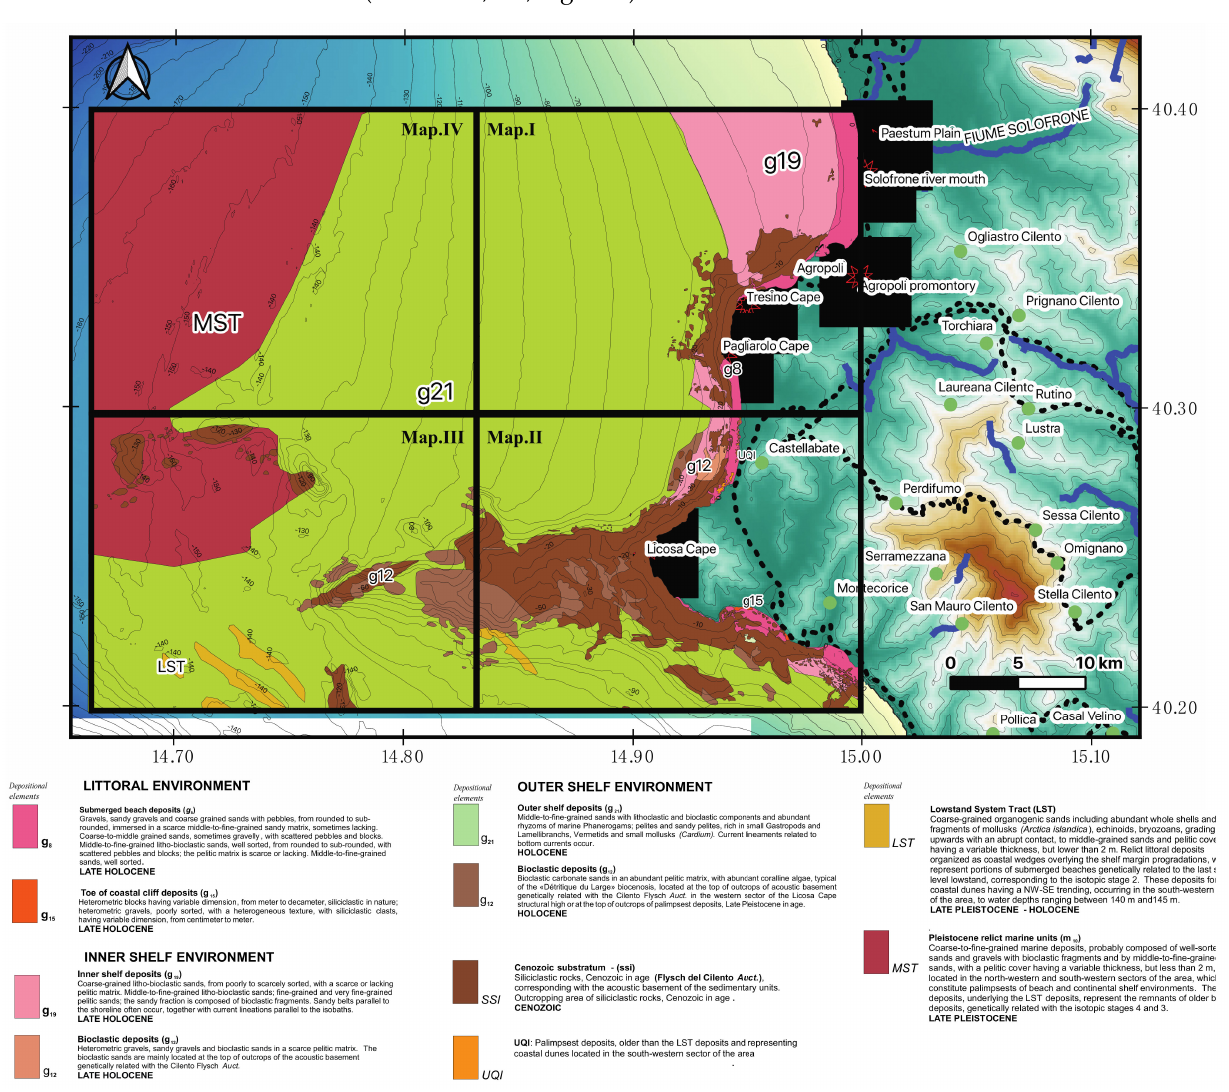
Figure 5. Onshore–offshore DEM of the Cilento Promontory with superimposed the results of the marine geological survey at the 1:25,000 scale (map n. I NW, map n. II SW, map n. III SE and map n. IV